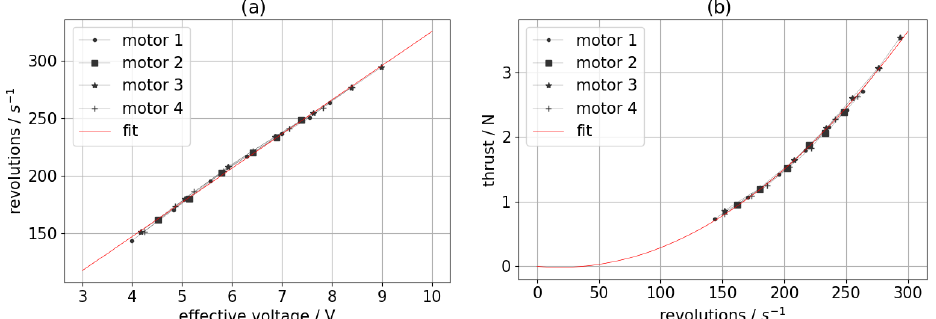
Figure 4. Calibration results of the motor test stand. (a) The calibration curve of revolution speed versus applied voltage and (b) the thrust coefficient curve. The fitted calibration curves are shown as red